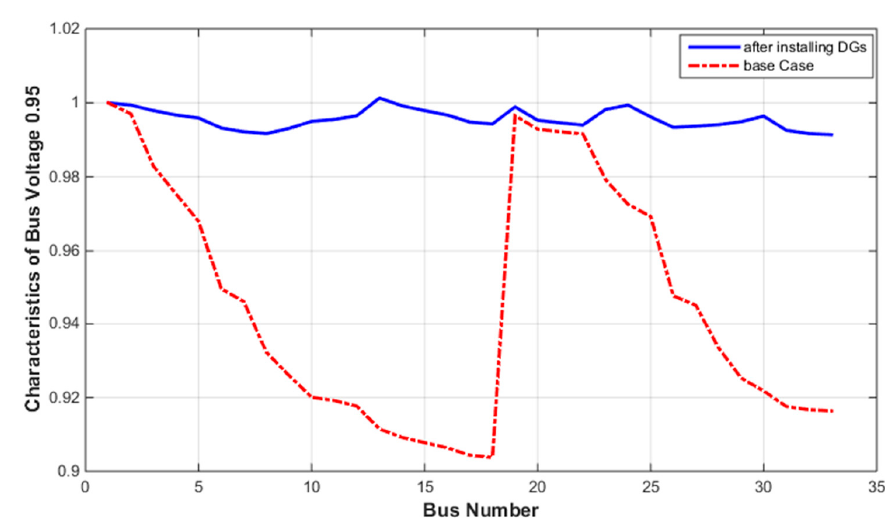
Energies 2020 , 13 , x FOR PEER REVIEW Figure 12. Characteristics of bus voltage, 33 bus system 0.95 pf. Figure 12. Characteristics of bus voltage, 33 bus system 0.95 pf. Figure 12. Characteristics of bus voltage, 33 bus system 0.95 pf.